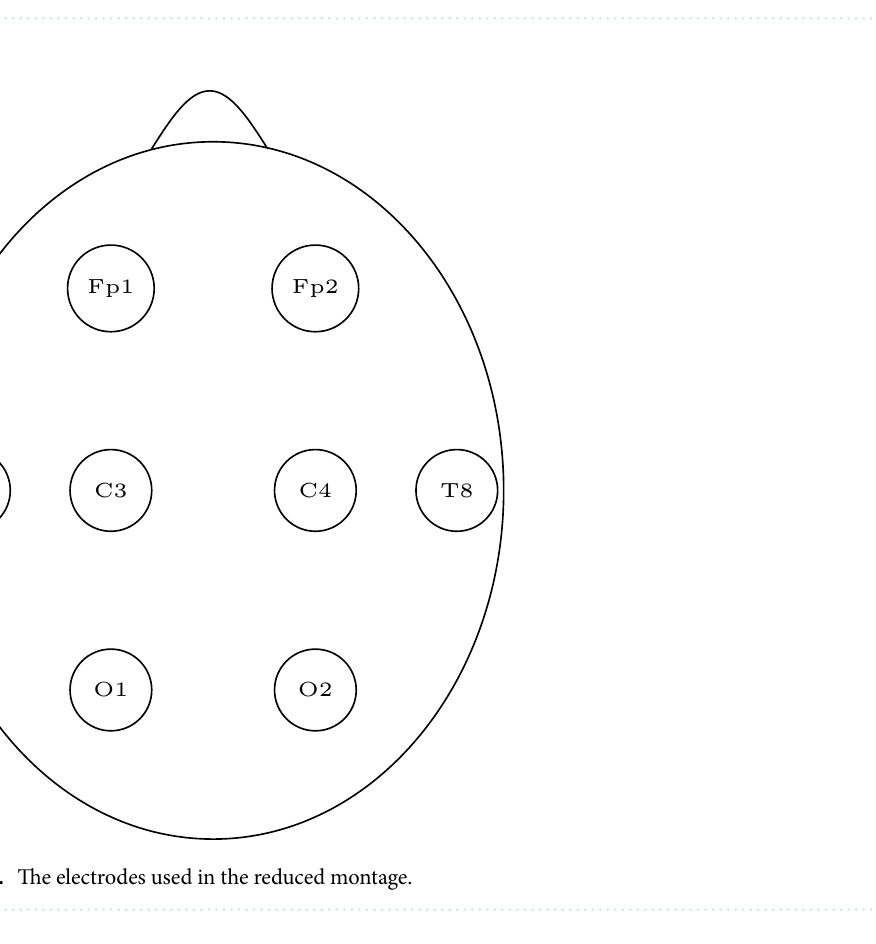
Table 1. Overview of the EEG files present for a single seizure along with the assignment to the two reviewers. In this case, Reviewer A was selected to review the full montage EEG containing the seizure pattern.